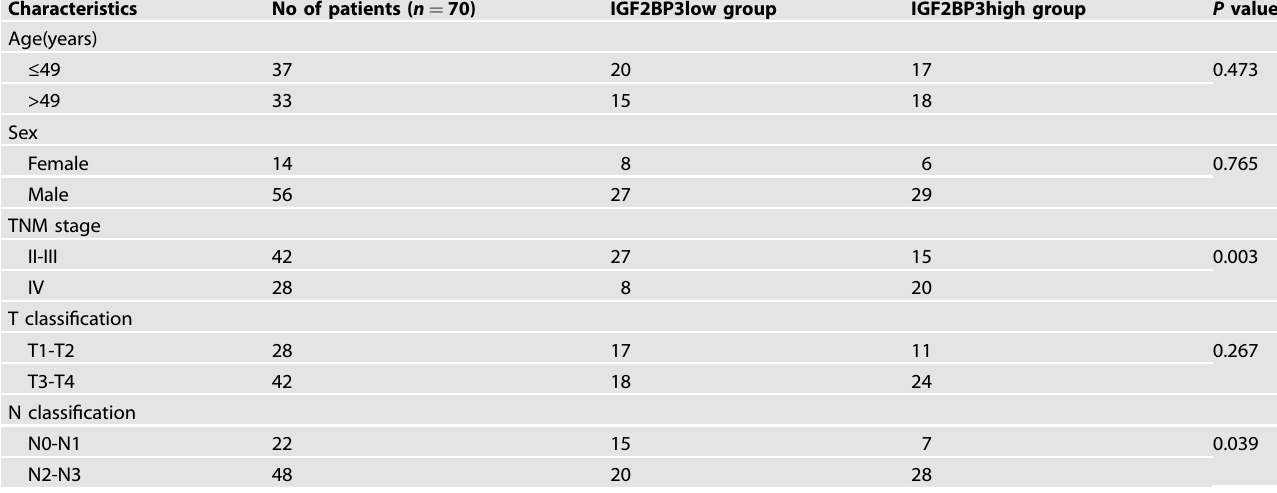
Table 1. Correlation between IGF2BP3 expression and clinical characteristics of NPC